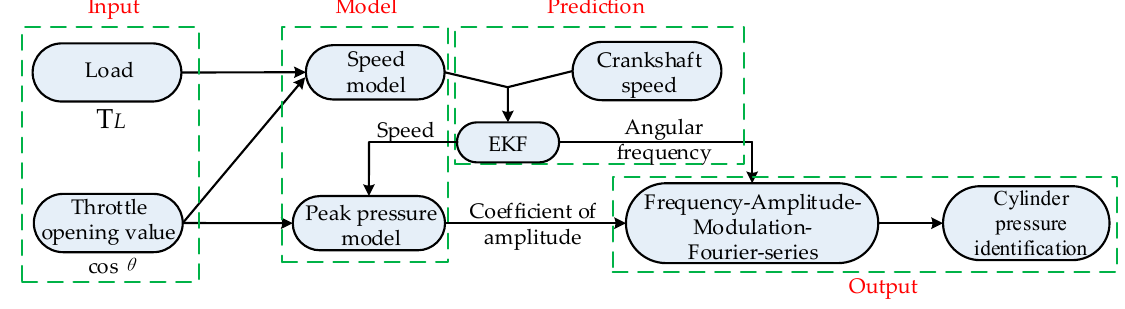
Figure 1. Flow chart of method.